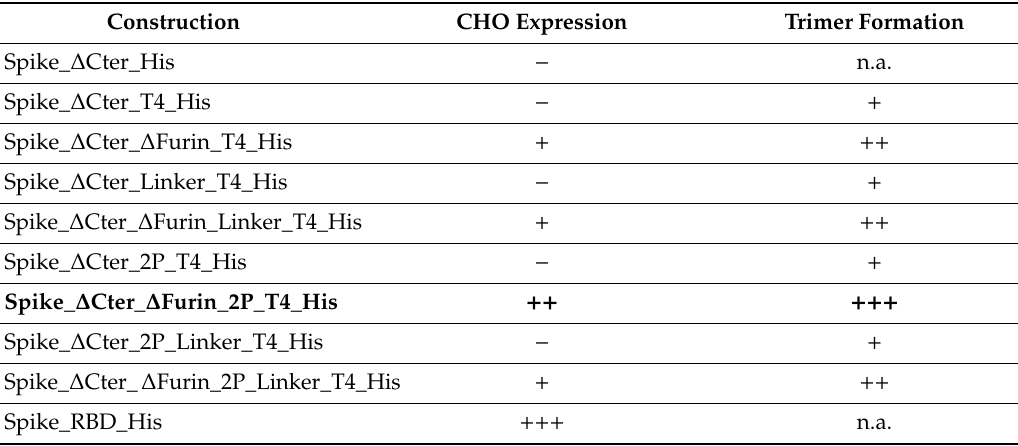
Table 1. Overview of the relative expression levels of the di ff erent SARS-CoV-2 Spike protein designs evaluated under fed-batch conditions, as well as their ability to form trimers in culture supernatants. ∆ Cter in the table refers to a construct that has the transmembrane and intracellular (TM, CT) section of the protein